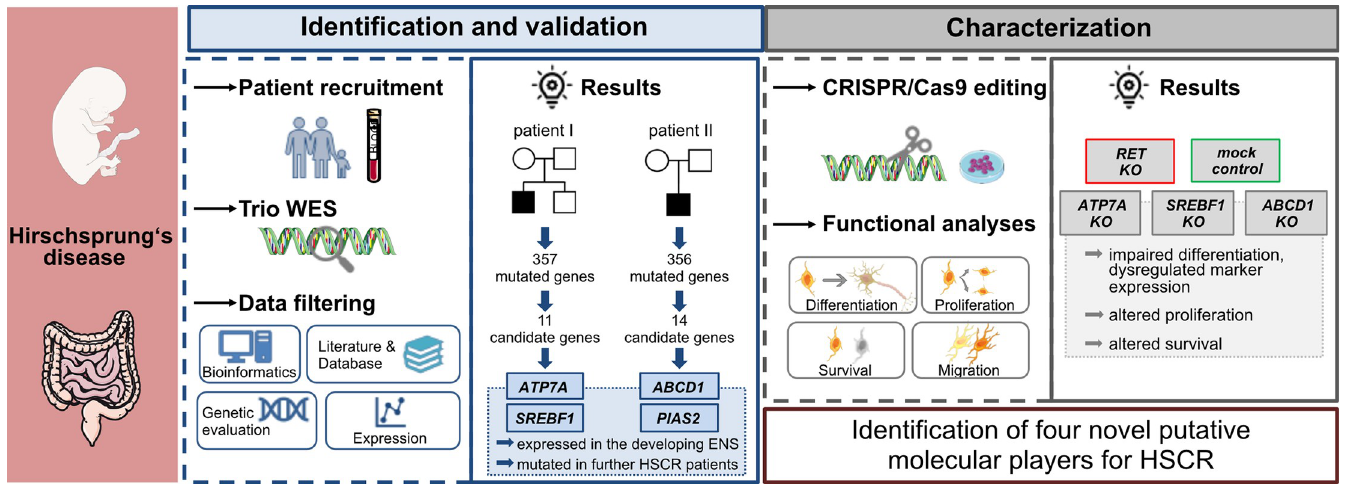
Fig 5. Study summary. HSCR candidate gene identification and validation was achieved by trio WES and various data filtering steps. Two promising candidate genes were selected per patient ( ATP7A , SREBF1 for patient I; ABCD1 , PIAS2 for patient II) and were characterized using gene-specific KO cell clones. Functional analyses revealed impaired neuronal functions thereby validating the selected genes as putative molecular players for HSCR. Figure components were kindly provided from Microsoft Office Power Point and Servier Medical Art (https://smart.servier.com/). This work is licensed under the Creative Commons Attribution 3.0